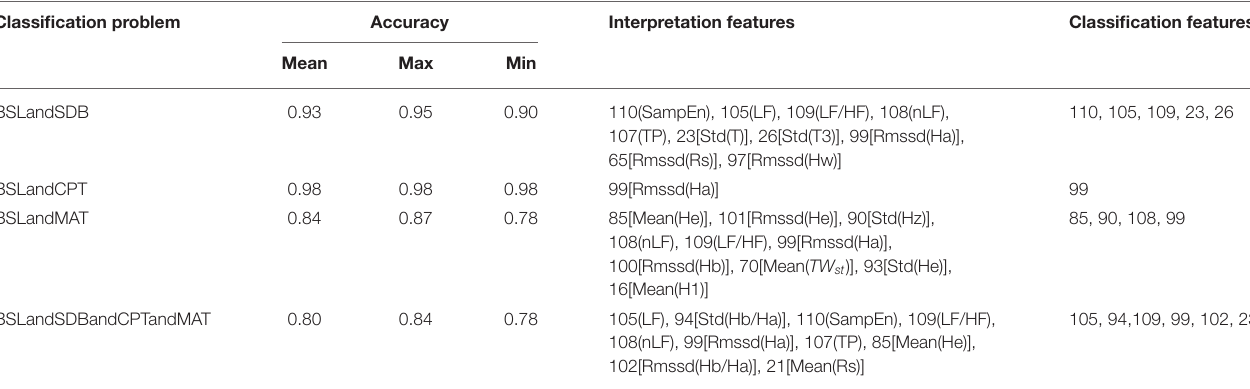
TABLE 2 | Classification models based on all PPG features. Classification problem